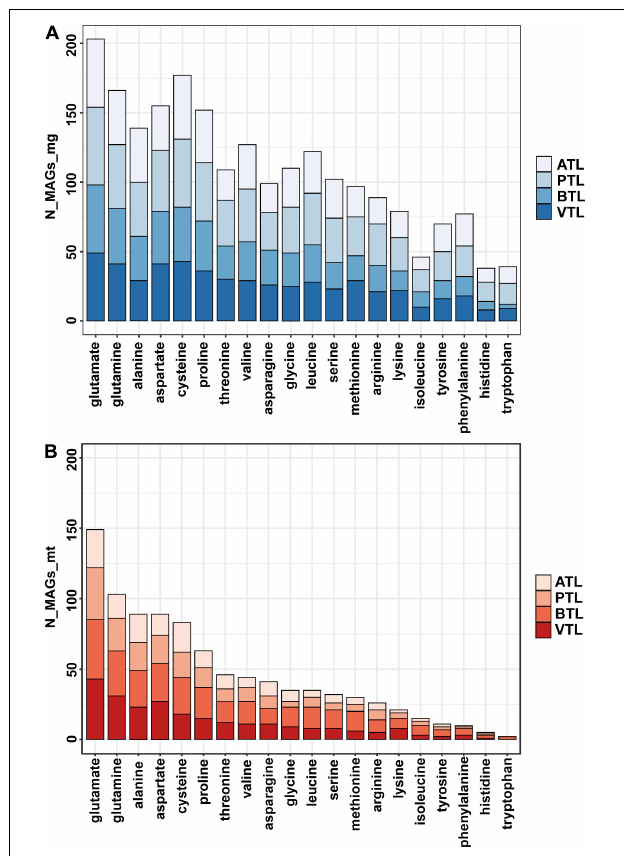
FIGURE 3 | The total number of MAGs which can synthesize each amino acid in different chemostats at genome level (A) and transcriptome level (B) . The ATL, PTL, BTL, and VTL represent the thermophilic methanogenic chemostats supplemented with acetate, propionate, butyrate, and isovalerate as sole carbon source, respectively. “N_MAGs_mg” represents the number of MAGs that can synthesize each amino acid at genome level. “N_MAGs_mt” represents the number of MAGs that can synthesize each amino acid at transcriptomic